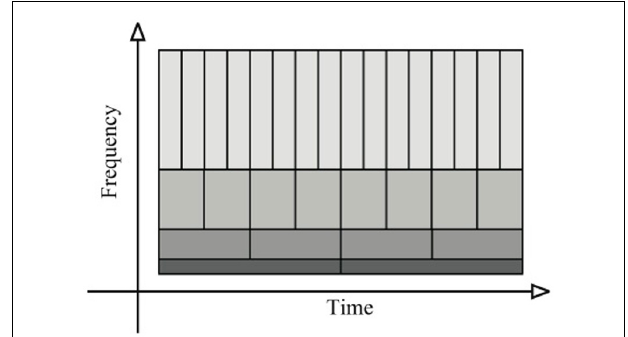
FIGURE 1 |Tiling of the time-frequency plane for the wavelet transform (WT) method. Narrow rectangles are used for the high frequencies that give a precise localization in time. Large rectangles are used for the low frequencies that give a precise localization in frequency.This illustrates the trade-off between the accuracy in time and the accuracy in frequency.